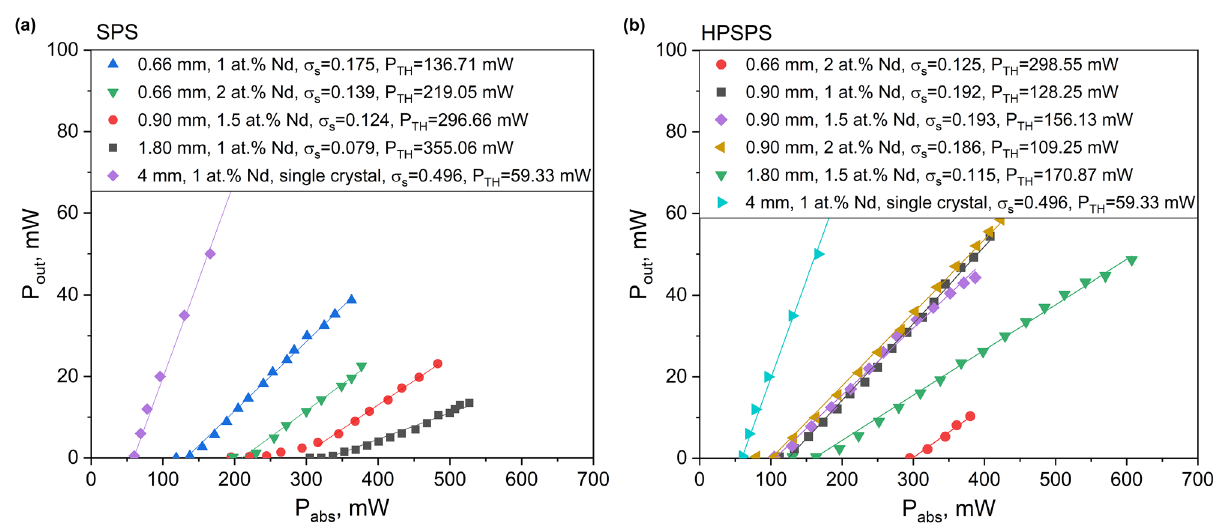
Figure 3. Laser efficiency slopes for ( a ) SPS- and ( b ) HPSPS-processed samples, including results for a commercial single crystal shown for